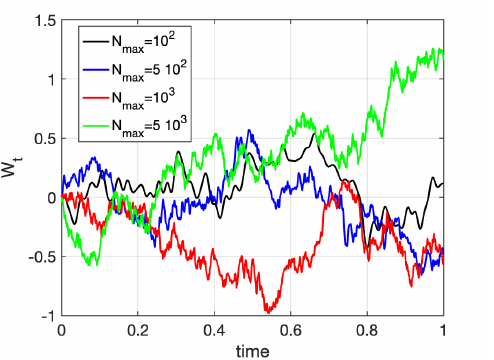
Figure 1. Karhunen–Loeve representation of a Wiener process on the interval t ∈ [ 0,1 ] , calculated with different numbers N max of basis